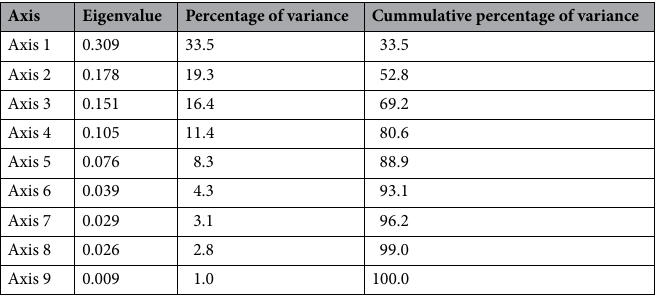
Table 2. Eigen values and percentage variance of all